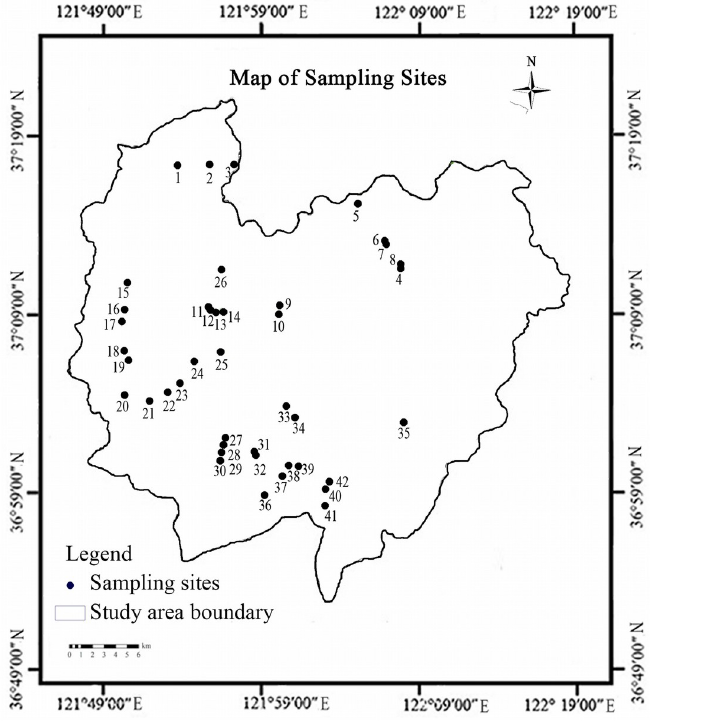
Fig 1. Map of the study area showing the groundwater sampling